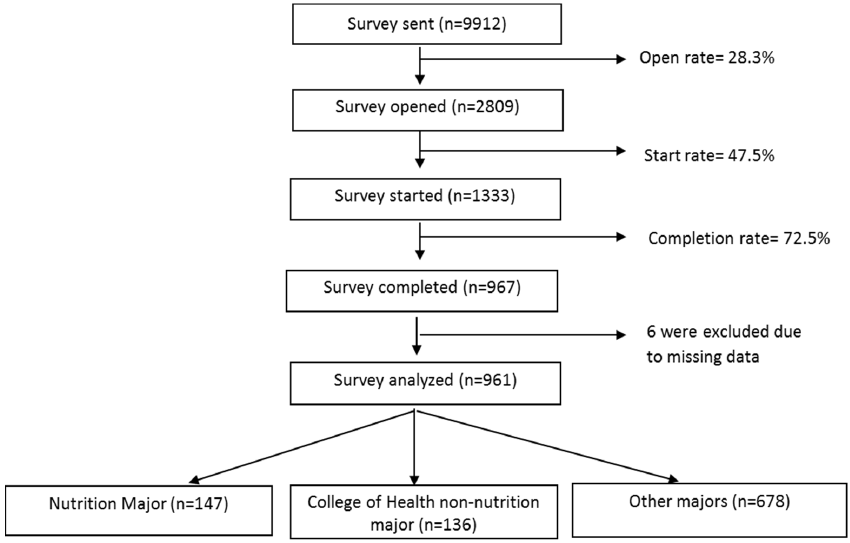
Figure 1. Study profile.